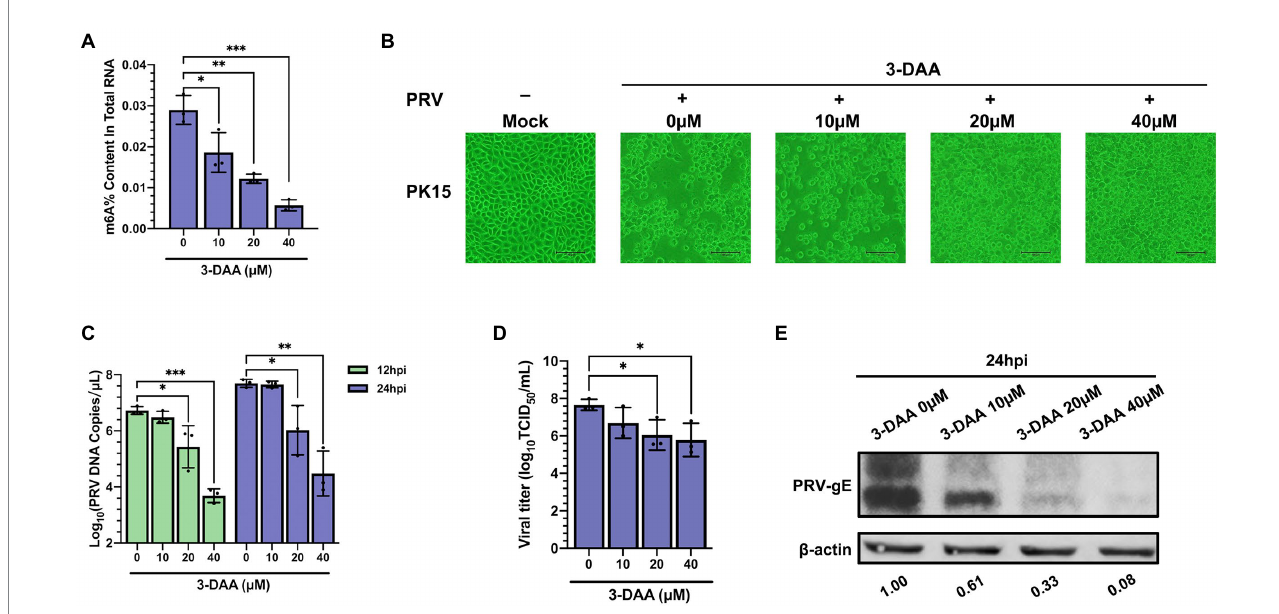
FIGURE 8 Inhibition of PRV infection by methylation inhibitor 3-deazaadenosine (3-DAA). (A) PK15 cells were treated with the specified concentrations of 3-DAA for 24 h. m 6 A level quantification was performed by ELISA assays. (B) PK15 cells were treated with the specified concentrations of 3-DAA for 24 h. PK15 cells were infected with PRV-FJ01 (MOI = 0.01) for 24 h, and images of cytopathic effects were recorded (200×). (C) PK15 cells were treated with the specified concentrations of 3-DAA for 24 h. PK15 cells were infected with PRV-FJ01 (MOI = 0.01) for 24 h. PRV DNA copies were evaluated by RT-qPCR analysis. (D) PK15 cells were treated with the specified concentrations of 3-DAA for 24 h. PK15 cells were infected with PRV-FJ01 (MOI = 0.01) for 24 h. PRV titers were assessed by TCID 50 analysis. (E) PK15 cells were treated with the specified concentrations of 3-DAA for 24 h. PK15 cells were infected with PRV-FJ01 (MOI = 0.01) for 24 h. PRV gE was assessed by immunoblotting analysis. β -actin was used as a loading control. * p < 0.05, ** p < 0.01, *** p <